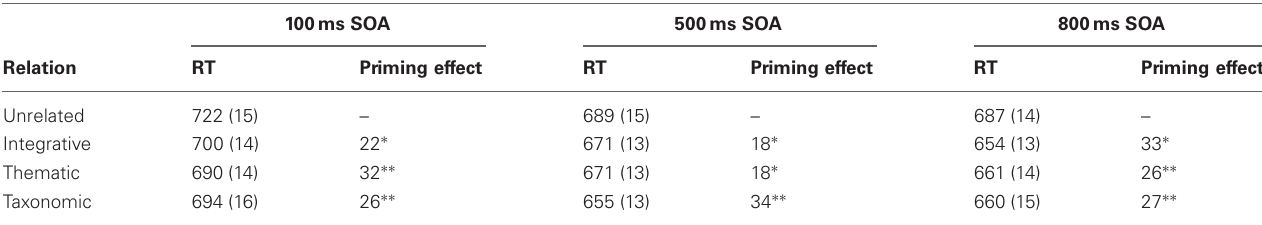
Table 6 | Study 4, Means and (SEs) of RTs (ms), Priming Effects (ms), and Predictors of Target RTs and Priming